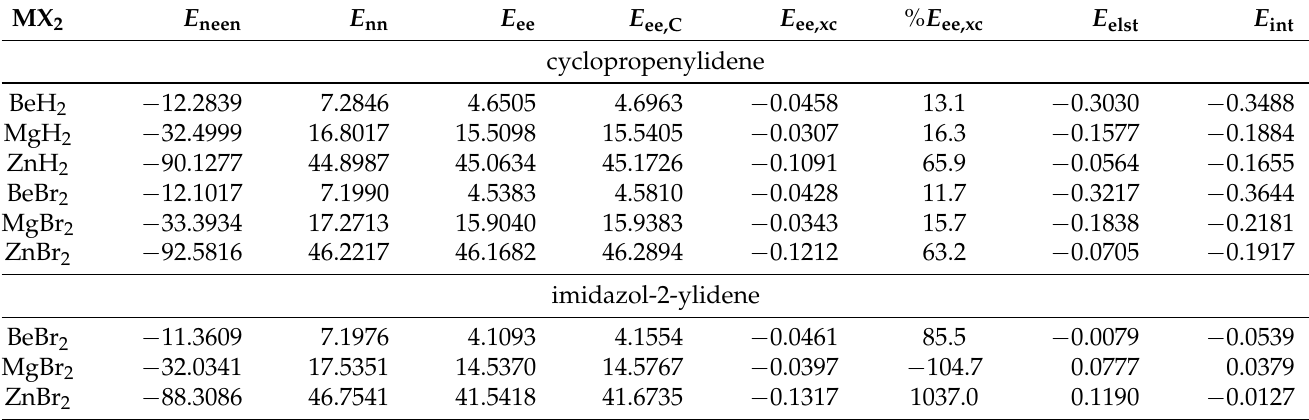
Table 2. The IQA-based energy (in a.u.) terms (see Methods) computed for the C · · · M interaction in the carbene · · · MX 2